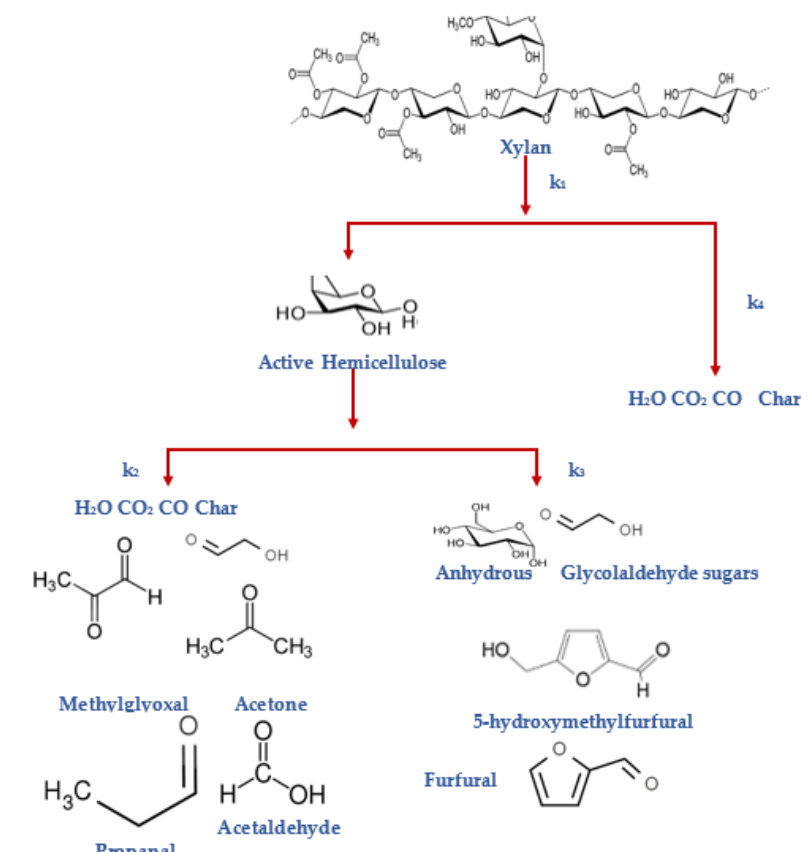
Figure 10. Reaction mechanism scheme of pyrolytic conversion of hemicellulose model compounds (adapted from [85]).